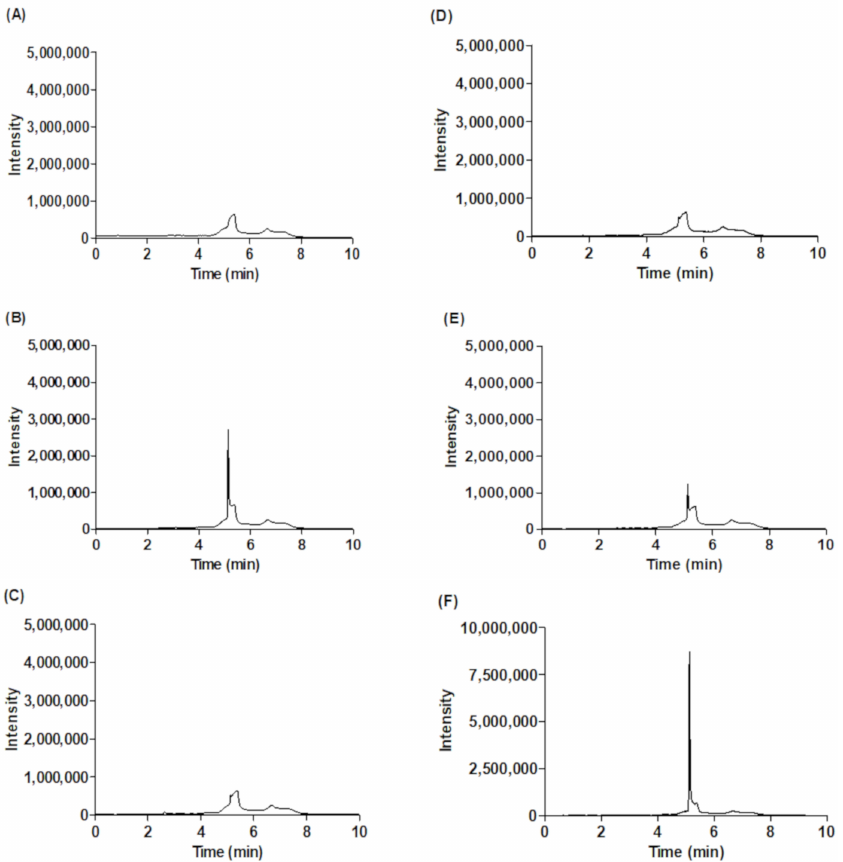
Figure 2. Chromatograms of l -carnitine derived from the fermented wild ginseng extract by LC / MS. ( A ) Blank (SIR: 162 m / z ), ( B ) l -carnitine standard (SIR: 162 m / z ), ( C ) the wild ginseng extract (SIR: 162 m / z ), ( D ) the autoclaved wild ginseng (SIR: 162 m / z ), ( E ) 1-day (SIR: 162 m / z ) and ( F ) 14-day (SIR: 162 m / z ) of fermented wild ginseng extract. Table 3. l -carnitine contents in fermented wild ginseng. Fermented Wild Autoclaved- Control * Control